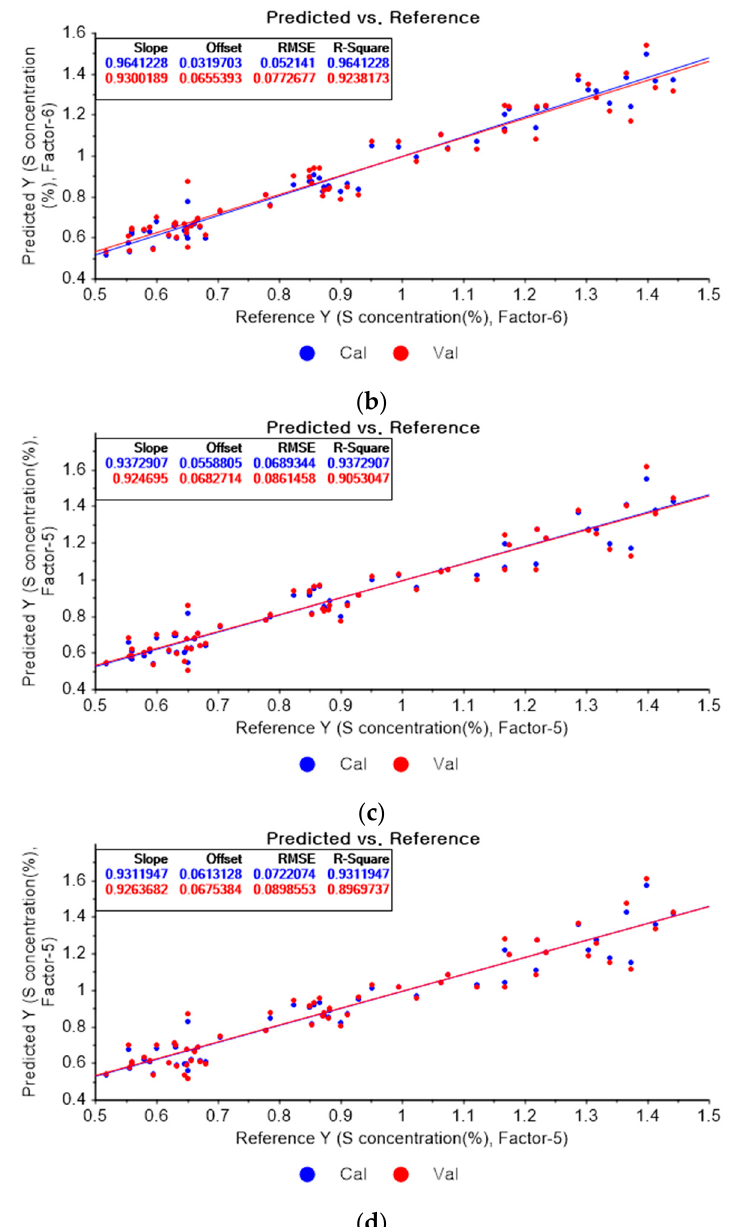
Figure 14. PLSR model of sulfur concentration employing the ( a ) original data and PLSR models pre-processed by SG derivative using ( b ) second-order derivative and second-order polynomial with one point, ( c ) second-order derivative and second-order polynomial with three points, and ( d ) second-order derivative and second-order polynomial with five points. The measured and predicted sulfur concentrations are presented in Figure 15. The maximum relative errors were 32.11, 20.13, and 18.84% for the PLSR model using the original data and the PLSR models pre-processed by the SG-smoothing and SG derivative methods, respectively. The relative error was the lowest in the PLSR model that adopted the SG derivative